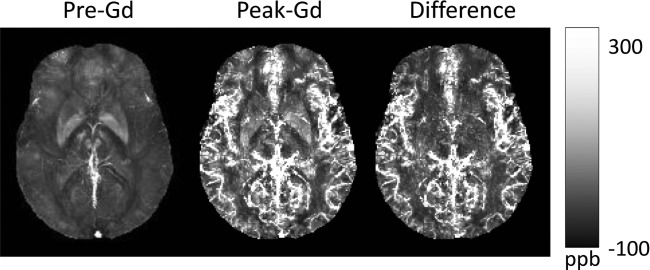
Quantitative susceptibility mapping for quantifying paramagnetic contrast agents. In an in vivo dynamic gadolinium (Gd) enhancement study of the brain, time-resolved Quantitative susceptibility mapping (QSM) was developed using spiral readout and temporal resolution acceleration with constrained evolution reconstruction (TRACER) complex image reconstruction. The difference image divided Gd molar susceptibility generates time-resolved Gd concentration map. Source: Xu et al, MRM 2014, epub.